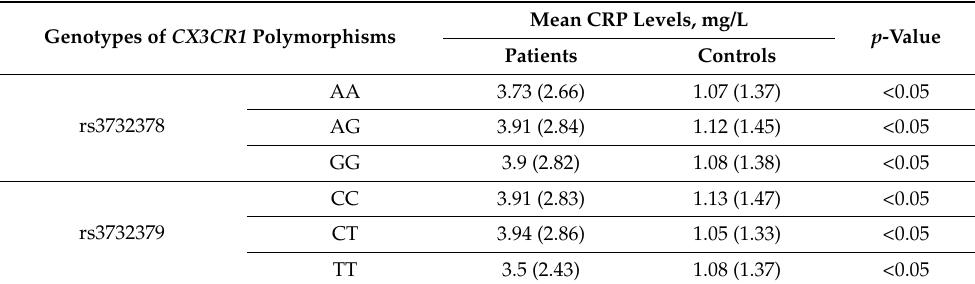
Table 4. Differences in mean C-reactive protein (CRP) levels between patients with end-stage renal disease (cases) and controls by the genotype of rs3732378 and rs3732379 polymorphisms. Genotypes of CX3CR1 Polymorphisms